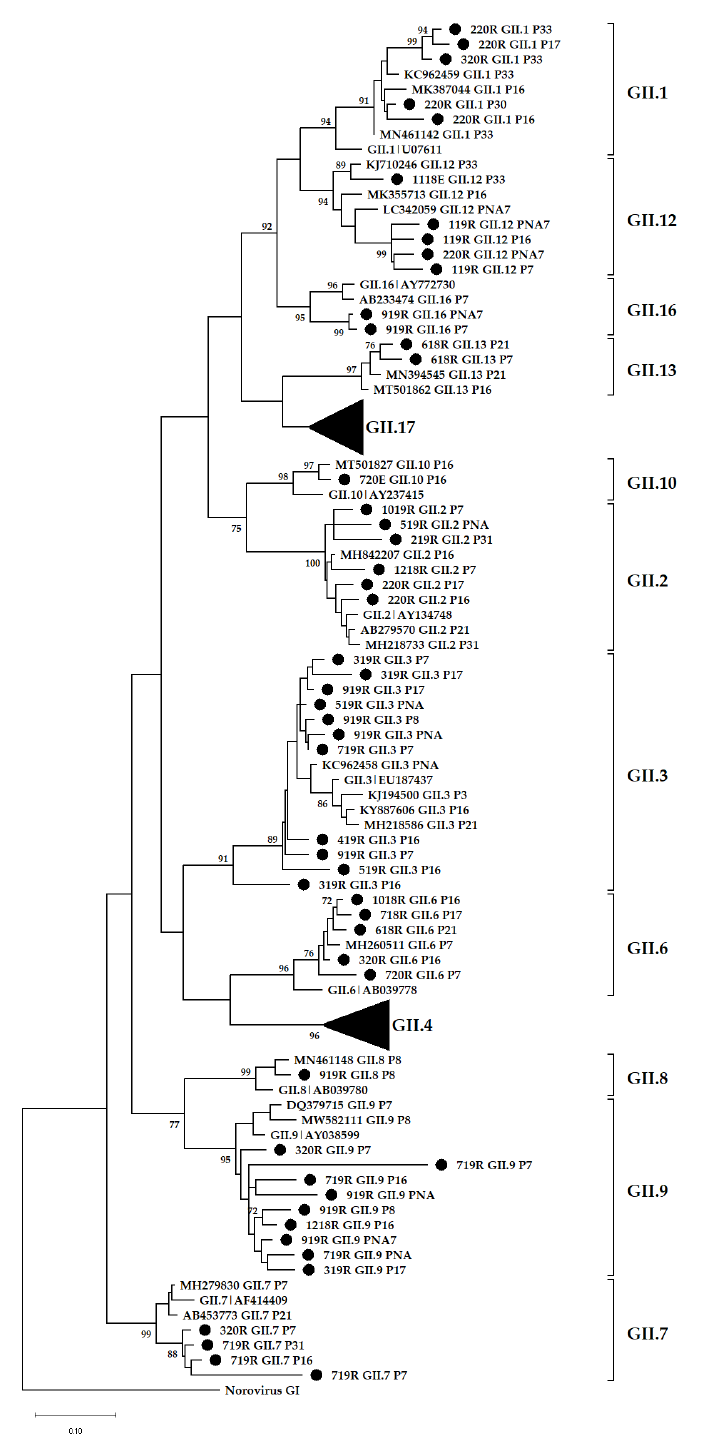
Figure 7. Phylogenetic analysis of the 305 bp at 5 (cid:48) -end of norovirus GII ORF2. Representative sequences identified in this study are indicated by black circles ( • ). All strain sequence names contain specific ID, genotype and P-type. Reference strains and the most closely related strains were downloaded from GenBank. The Maximum Likelihood phylogenetic trees were constructed using MEGA X software [46] and 1000 bootstrap replicates based on the Kimura 2-parameter model. The sequences were labelled according to month and year of detection, wastewater type, P-type and genotype, e.g., 618RGII.2[P2] = GII.2[P2] virus detected in raw sewage collected in June